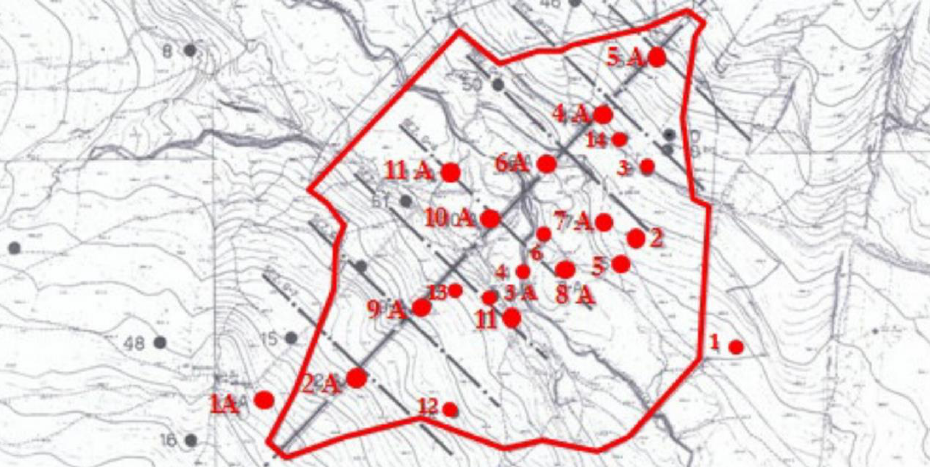
Figure 18. Location of collected survey samples.